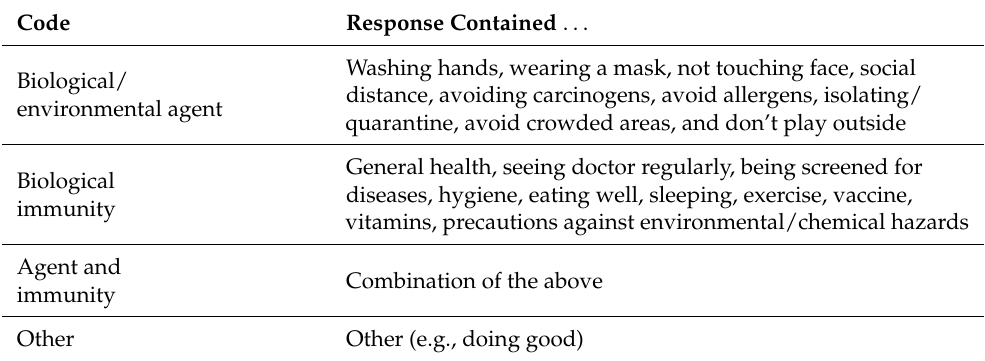
Table A4. Q6 (Prevention) “What, if anything, could (X) have done to stop himself from getting this condition?”.